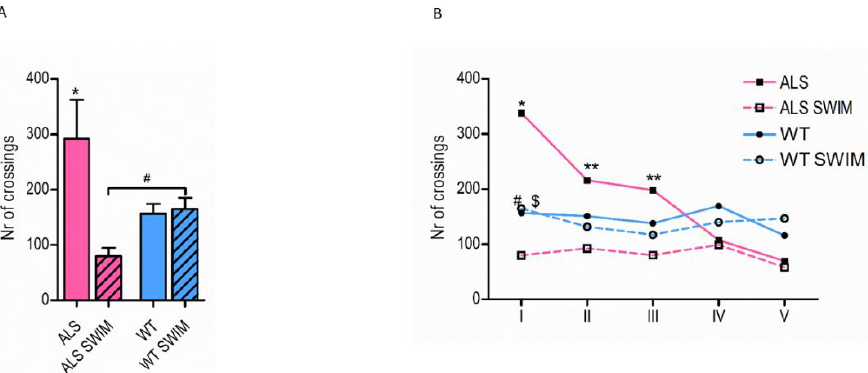
Figure 1. Swim training ameliorates the hyperlocomotor activity during the open field test: ( A ) Number of lines crossed during the first open field test at age 86 days, * p < 0.05 versus all of the other groups, # p < 0.05, LSD post hoc tests after one-way ANOVA. ( B ) Number of lines crossed in five consequent weeks, * p < 0.05 versus all of the other groups at the same time point and the same group at the III, IV, and V week, ** p < 0.05 versus all of the other groups at the same time point and the same group at IV and V week, for WT group # p < 0.05 versus the same group at V week, for WT swim group $ p < 0.05 versus the same group at III week, LSD post hoc tests after repeated measures ANOVA was used for all the figures.